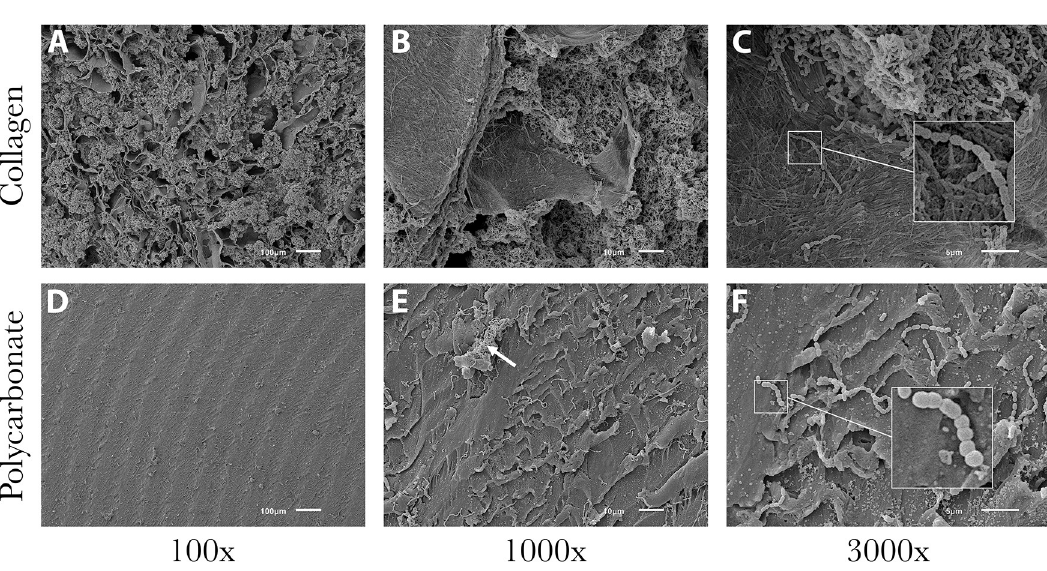
Fig 5. Representative SEM images of S . mutans ATCC 25175 biofilm formation on both material types. (A-C) Surface of collagen with biofilm coverage. Cells of S . mutans filled the ravines and crevices of the collagen material. (D-F) In contrast to collagen, S . mutans grew in small plumes on the surface of polycarbonate with sporadic coverage. Arrow (panel E) indicates a biofilm